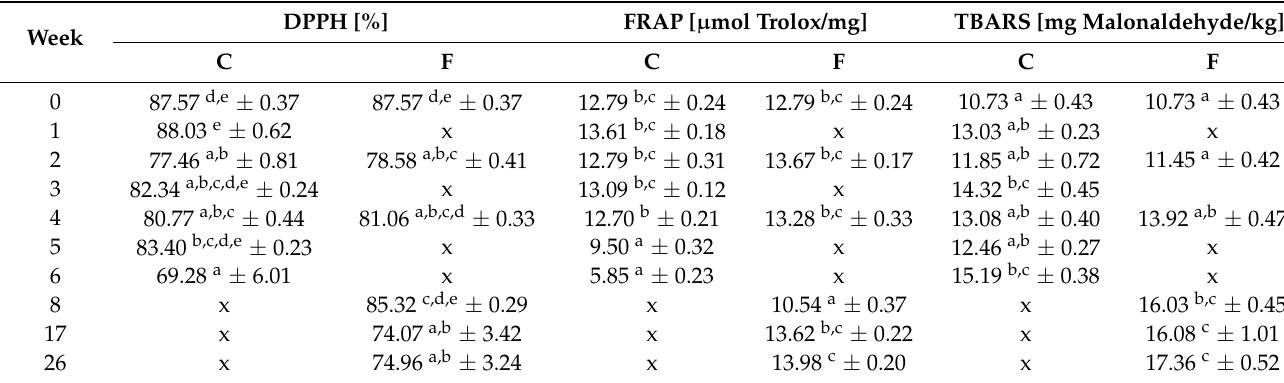
Table 2. Results of the shelf-life determination of the date bar with addition of fish industry by-products designed according to new